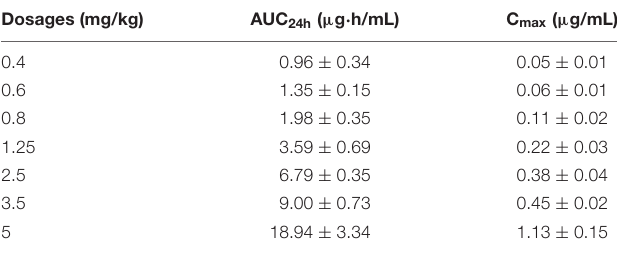
TABLE 1 | The pharmacokinetic parameters of danofloxacin following multiple doses in a piglet tissue-cage infection model. Dosages (mg/kg)